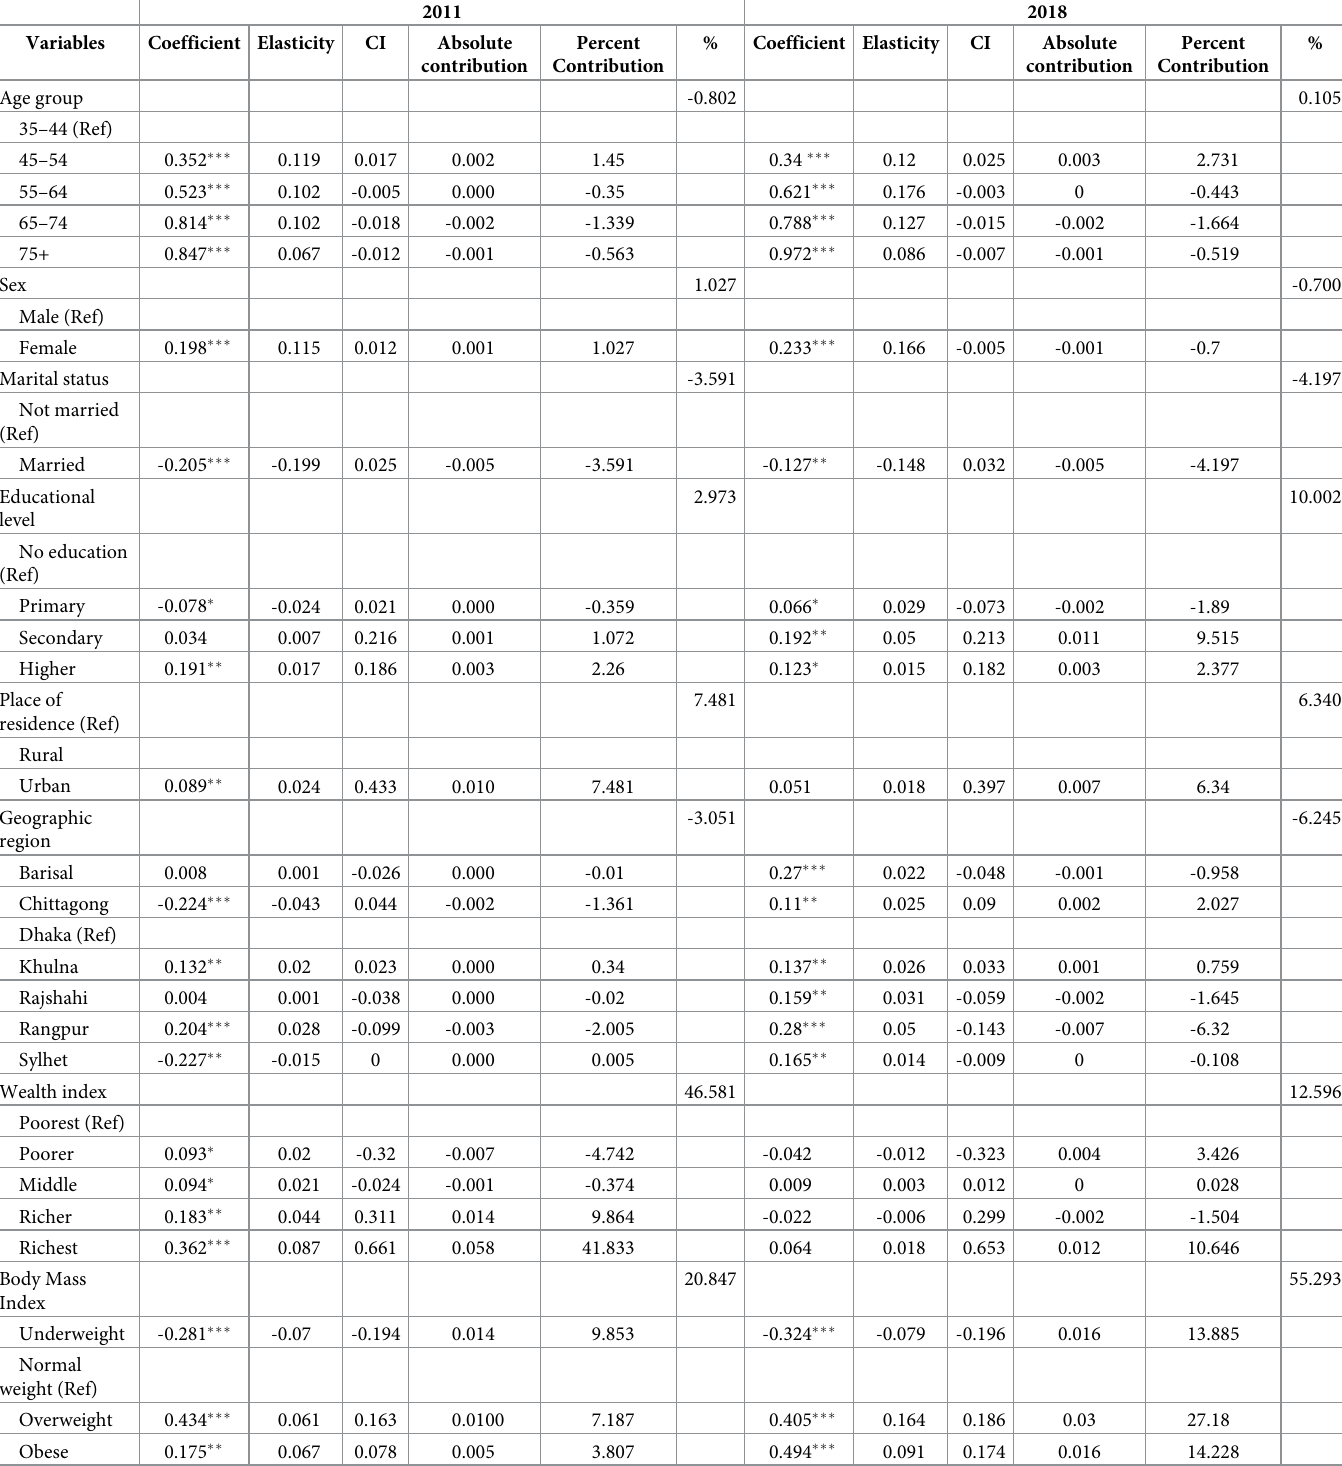
Table 4. Estimates of decomposition analysis for contribution of various explanatory variables for hypertension among adults in Bangladesh, 2011 BDHS and